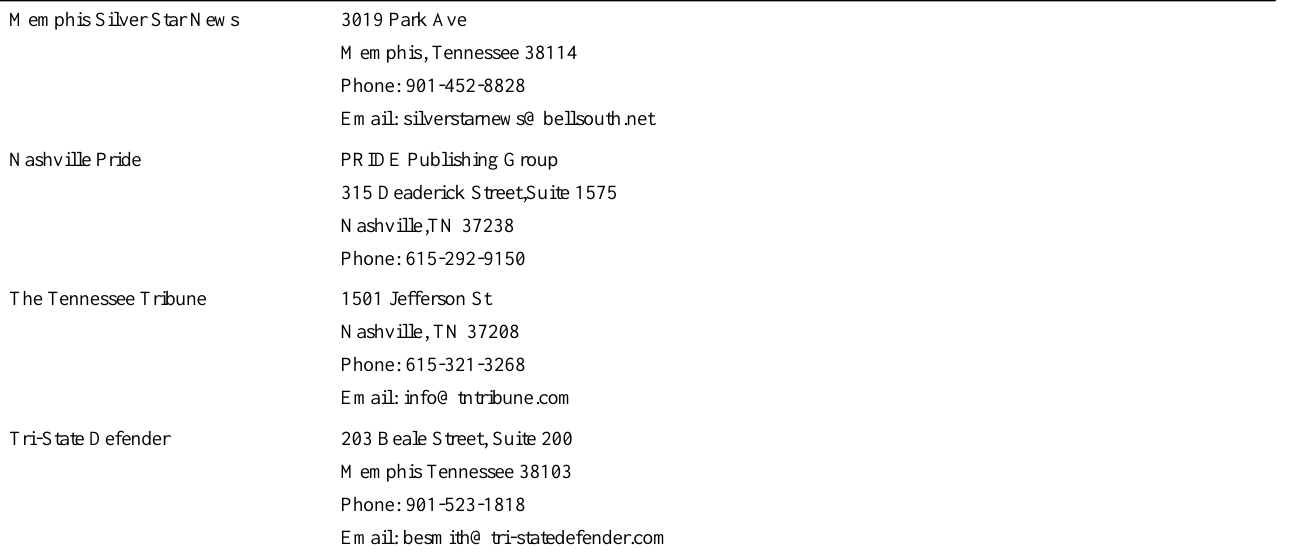
Table 1. Black community newspapers in the mid-south, United